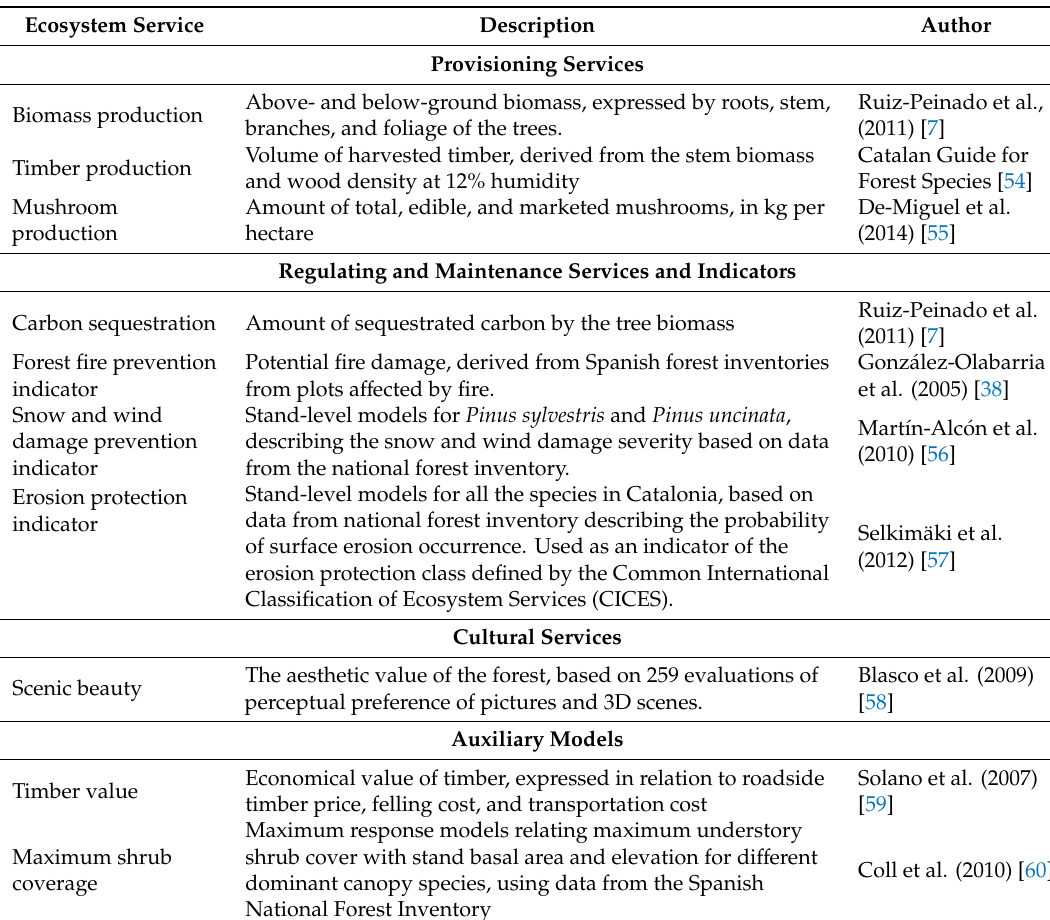
Table 1. Models used to quantify ecosystem services and risk reduction